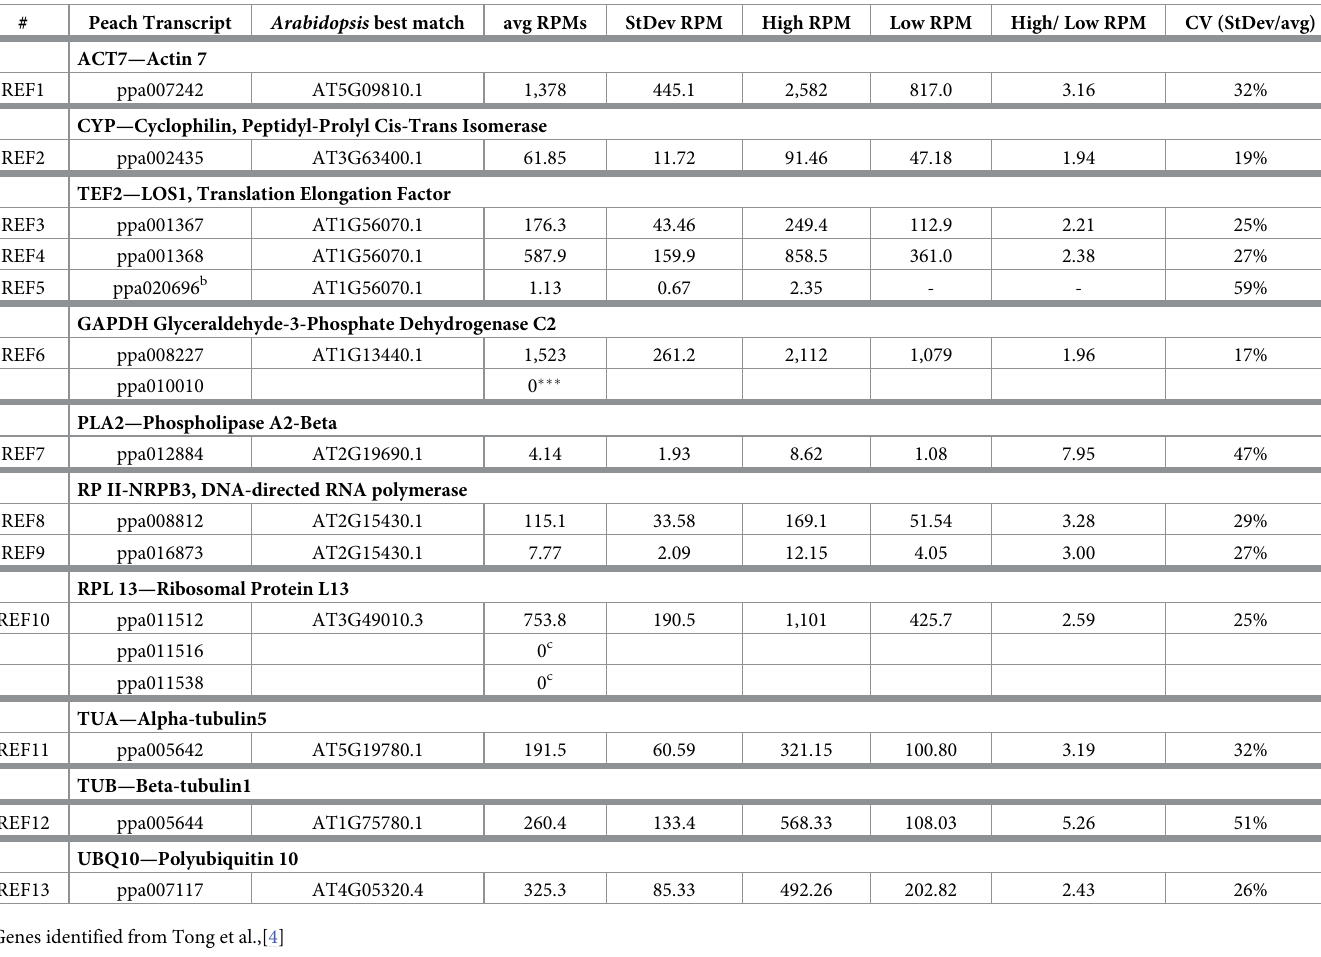
Table 1. Expression values of peach reference genes a in RNAseq libraries in